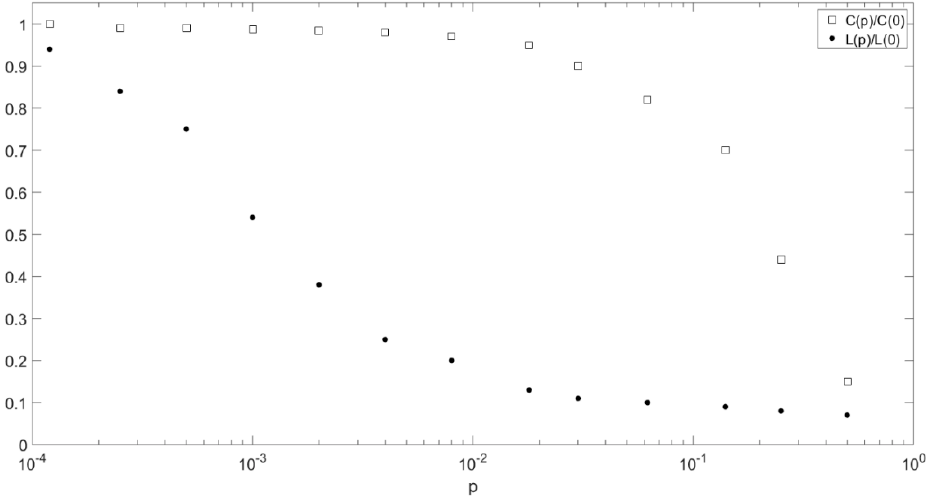
Figure 2. Path length 𝐿(𝑝) and clustering coefficient 𝐶(𝑝) for the family of randomly connected graph of Figure 1.